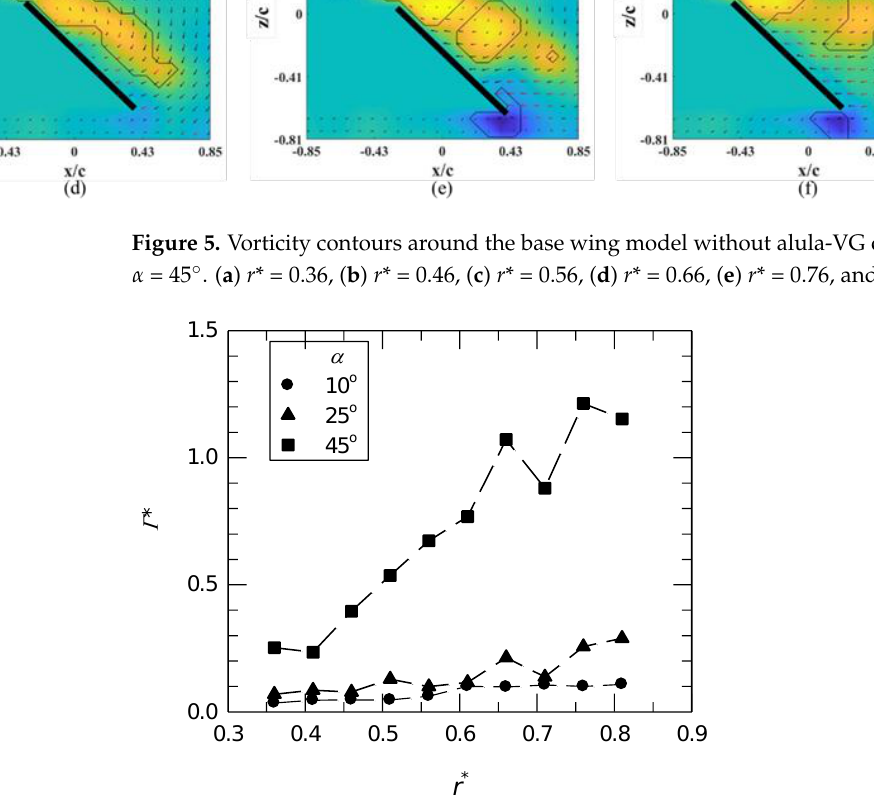
Figure 6. The normalized circulation ( Γ * ) of the base wing model on different x-z planes at different angles of attack.